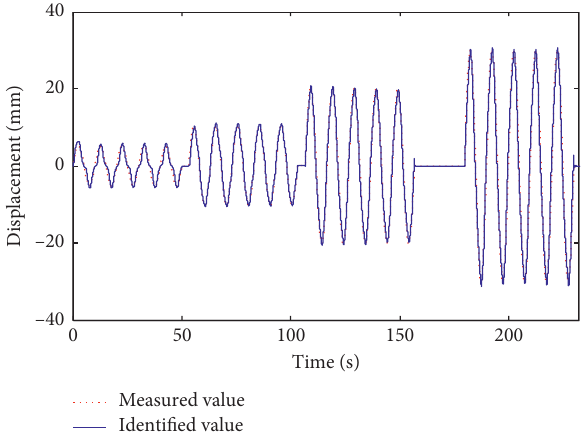
Figure 7: Comparison between identified displacements and measured